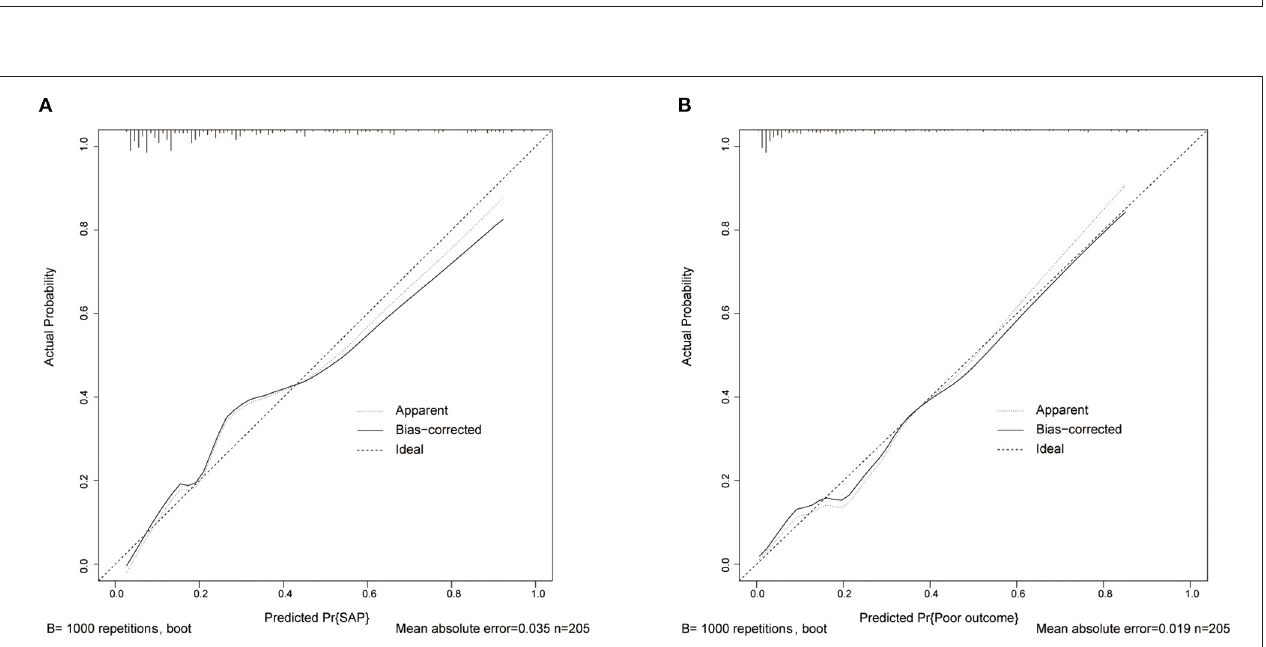
FIGURE 5 | Calibration curve of SAP and poor outcome models in data. (A) Calibration curve of the SAP model. (B) Calibration curve of the outcome model. SAP, stroke-associated pneumonia.